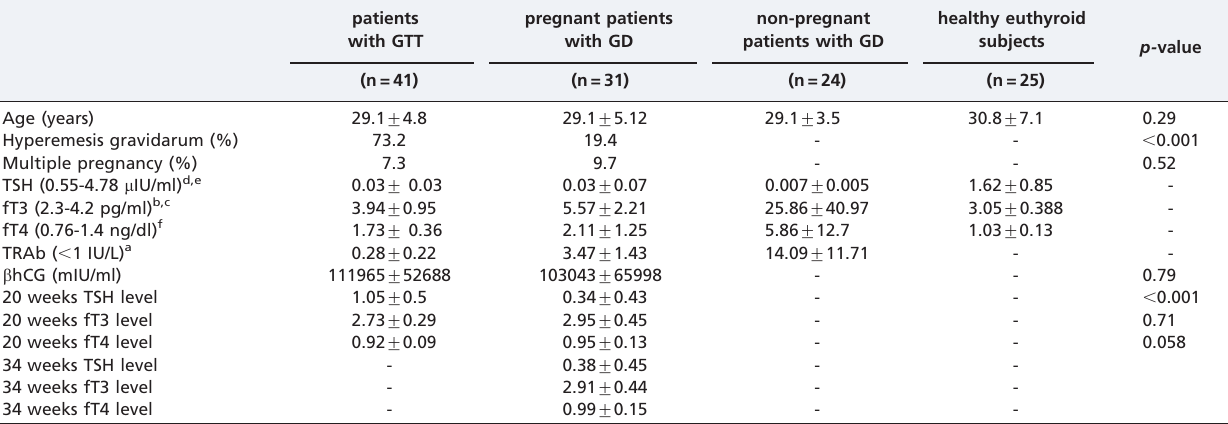
Table 1 - Demographic information and laboratory values of the study participants.